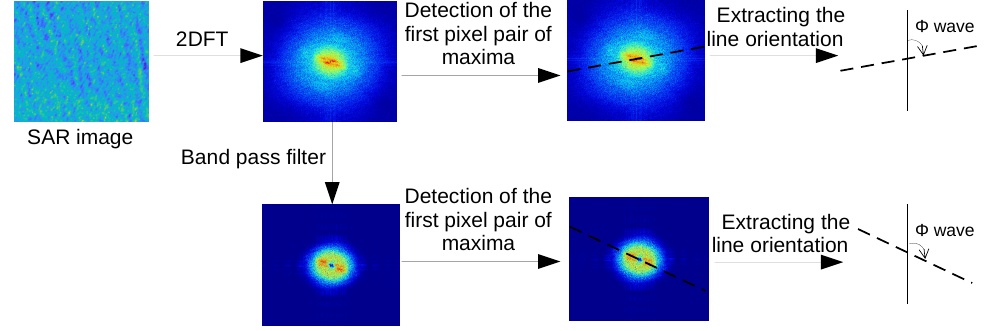
Figure 4. Summary of the 2DFT based